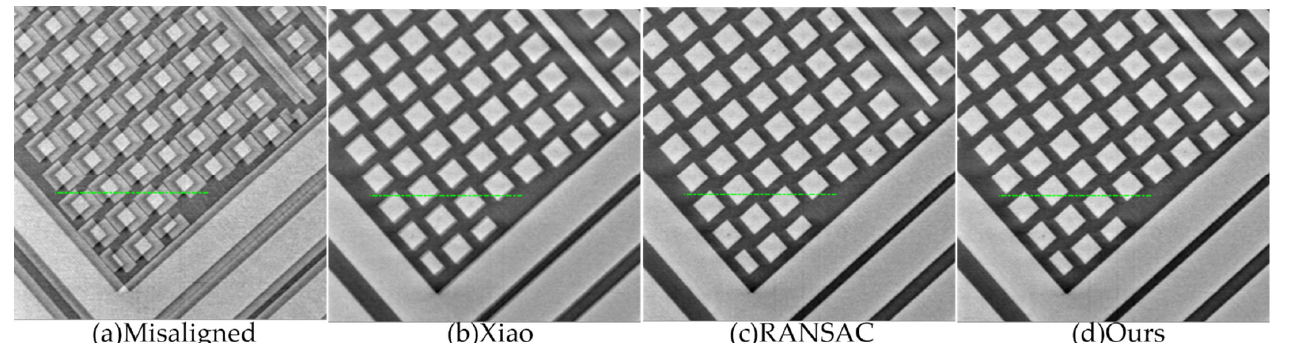
Figure 8. The Chips data reconstruction results with different parameters. ( a ) Misaligned parameters. ( b ) Parameters calculated using Xiao et al.’s method. ( c ) RANSAC feature-point screening results. ( d ) Parameters calculated by our proposed method.